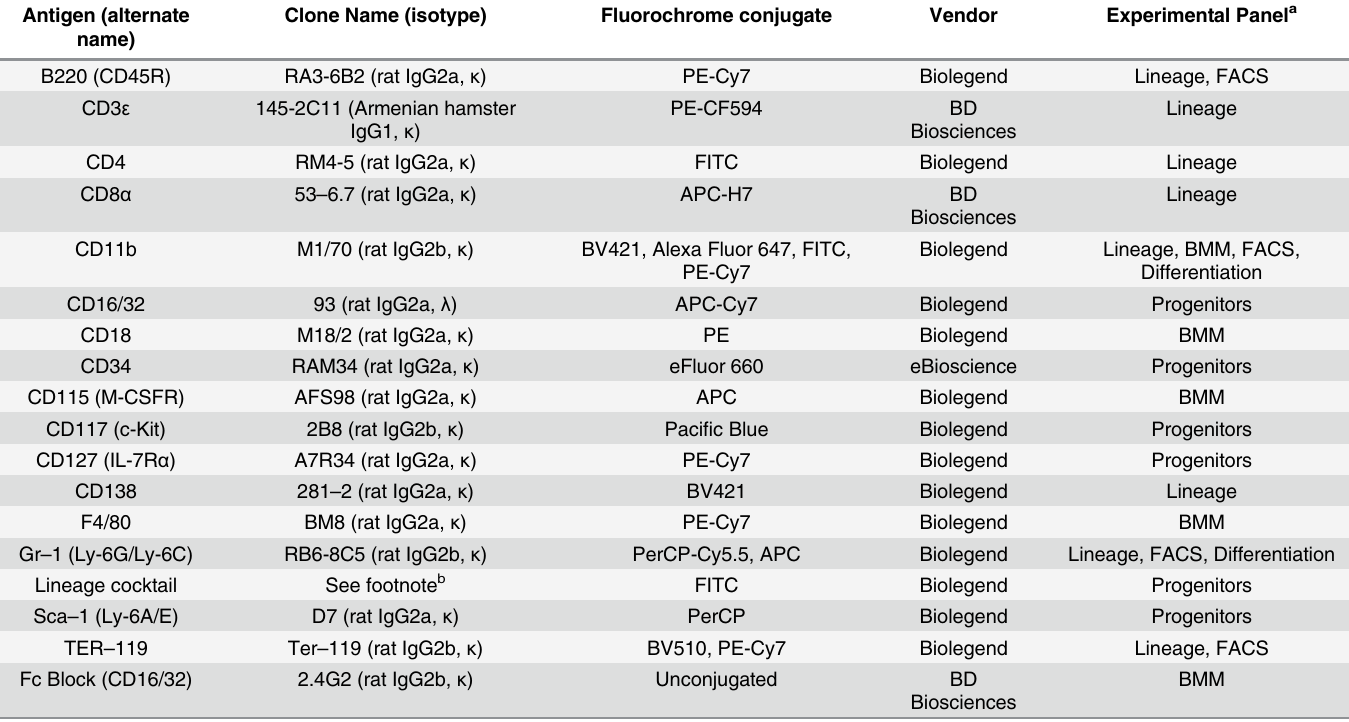
Table 1. Antibodies used for flow